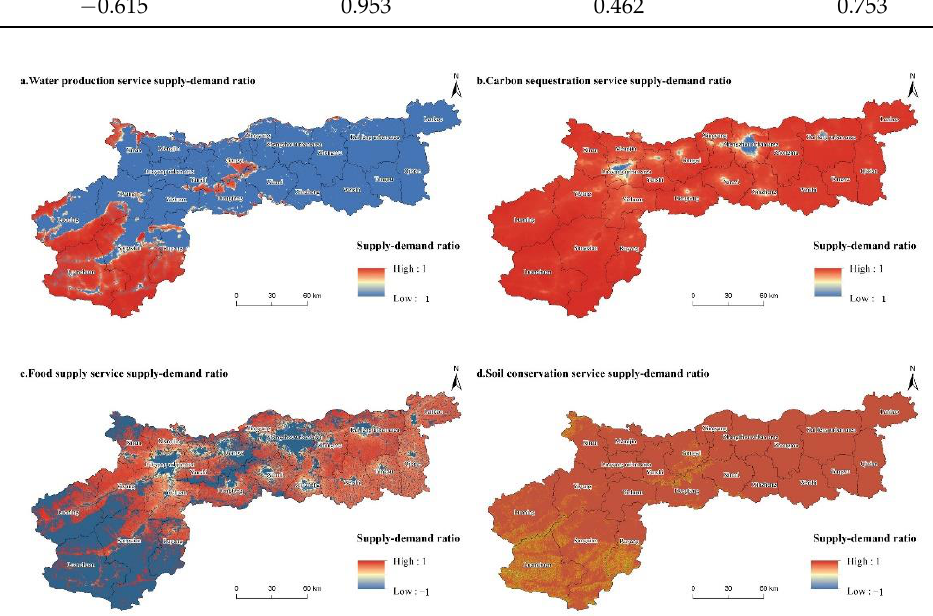
Figure 3. Distribution of the supply-demand ratios of ( a ) water production service, ( b ) carbon sequestration service, ( c ) food supply service, and ( d ) soil conservation service in the ZKL urban agglomeration. Table 3. Supply-demand ratios of ESs in all the districts and counties in the ZKL urban agglomera- tion.